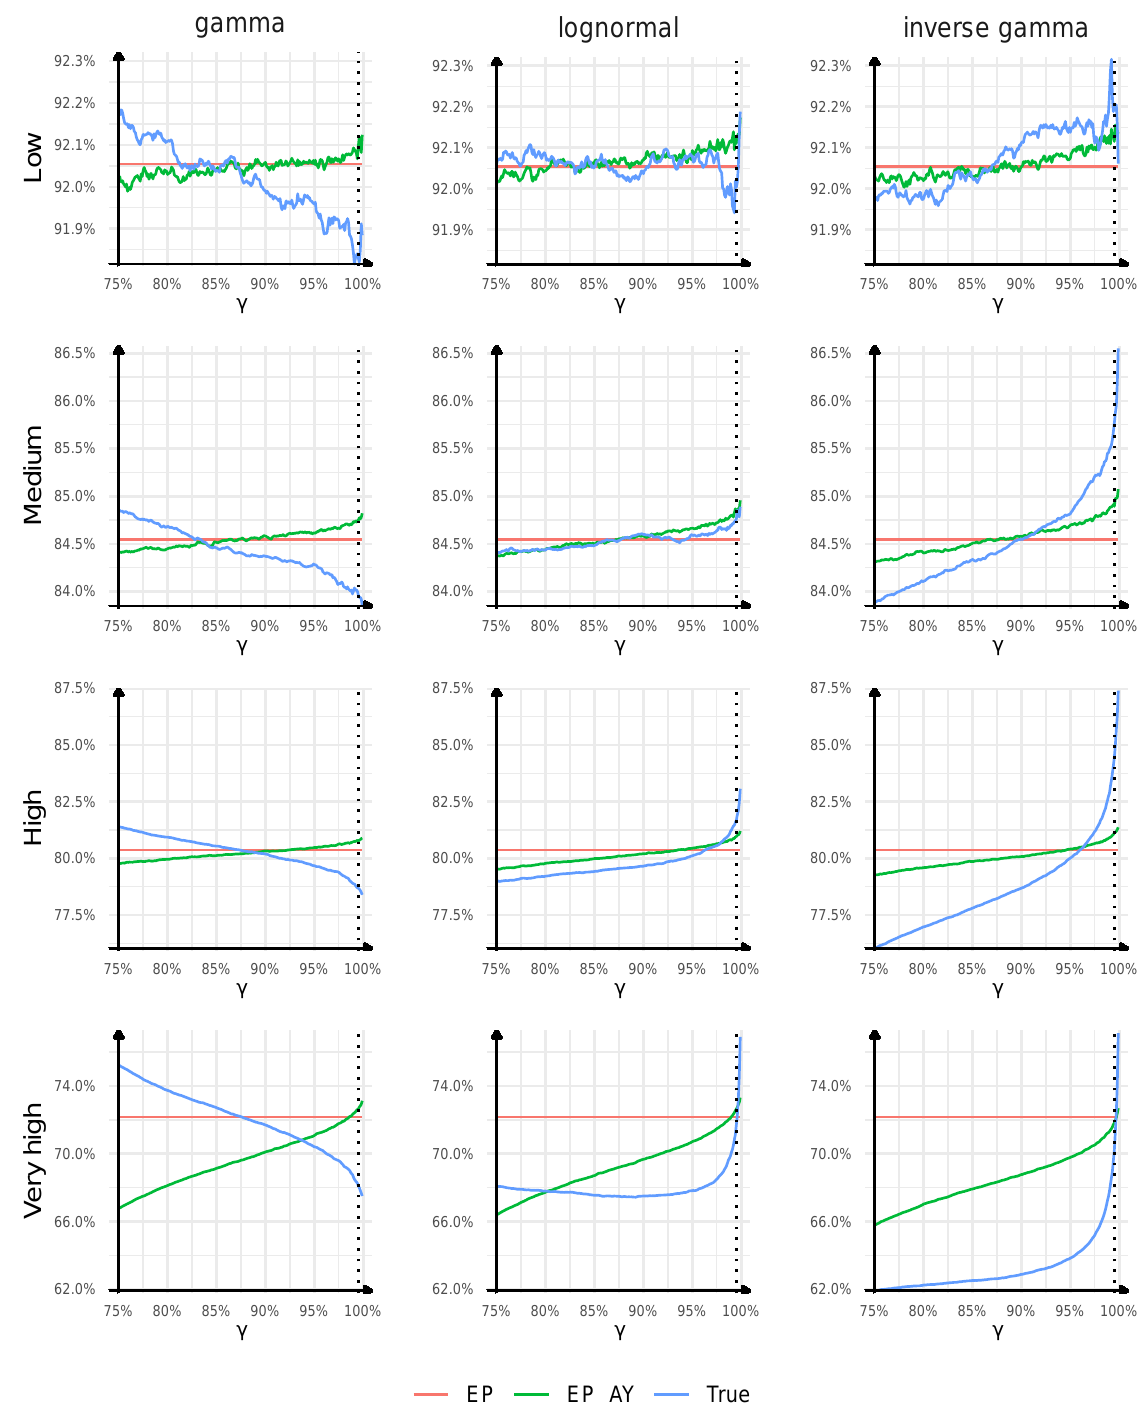
Figure 3. The ratios of Value-at-Risk measures for the one-year risk and the ultimate risk as a function of the confidence level—the case with the estimation